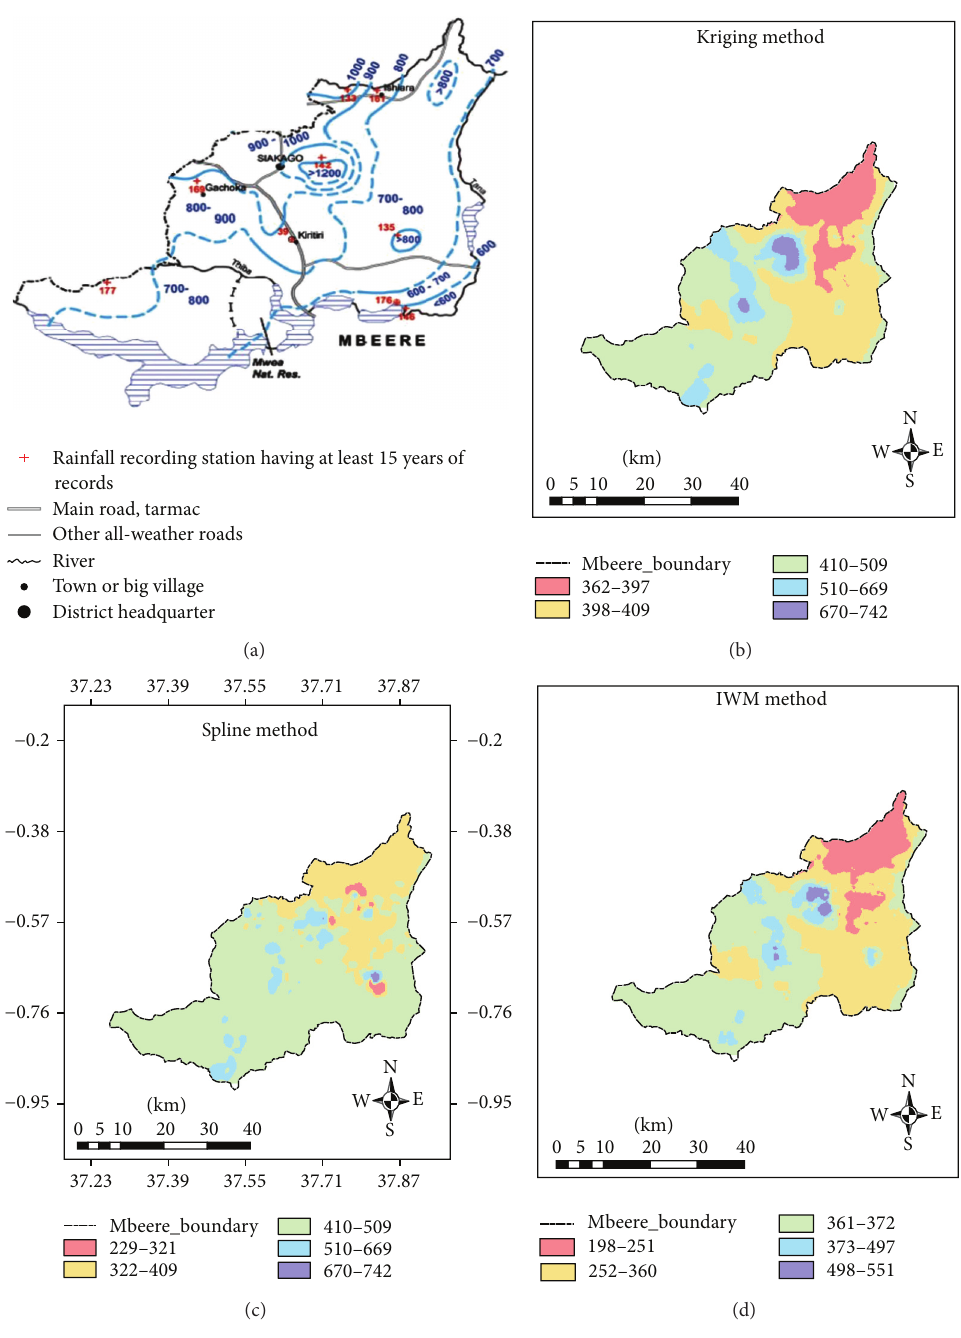
Figure 7: Annual rainfall maps of observed and those of reconstructed rainfall using IWM, Kriging, and Spline interpolation